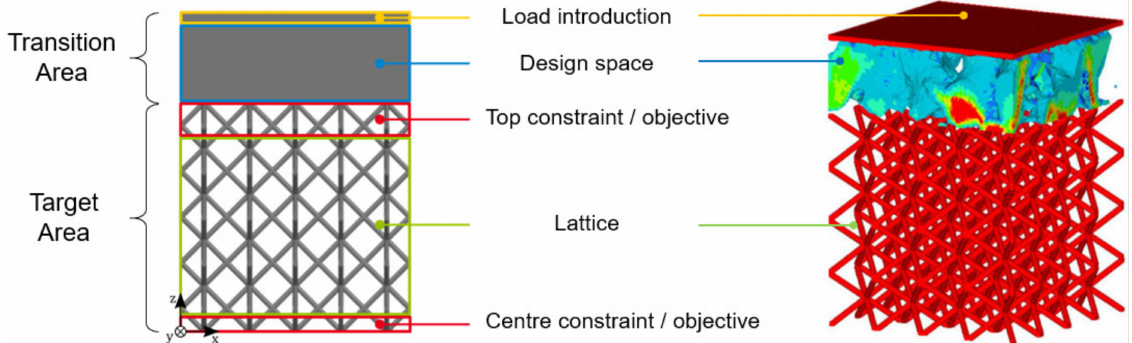
Figure 4. Topology optimisation